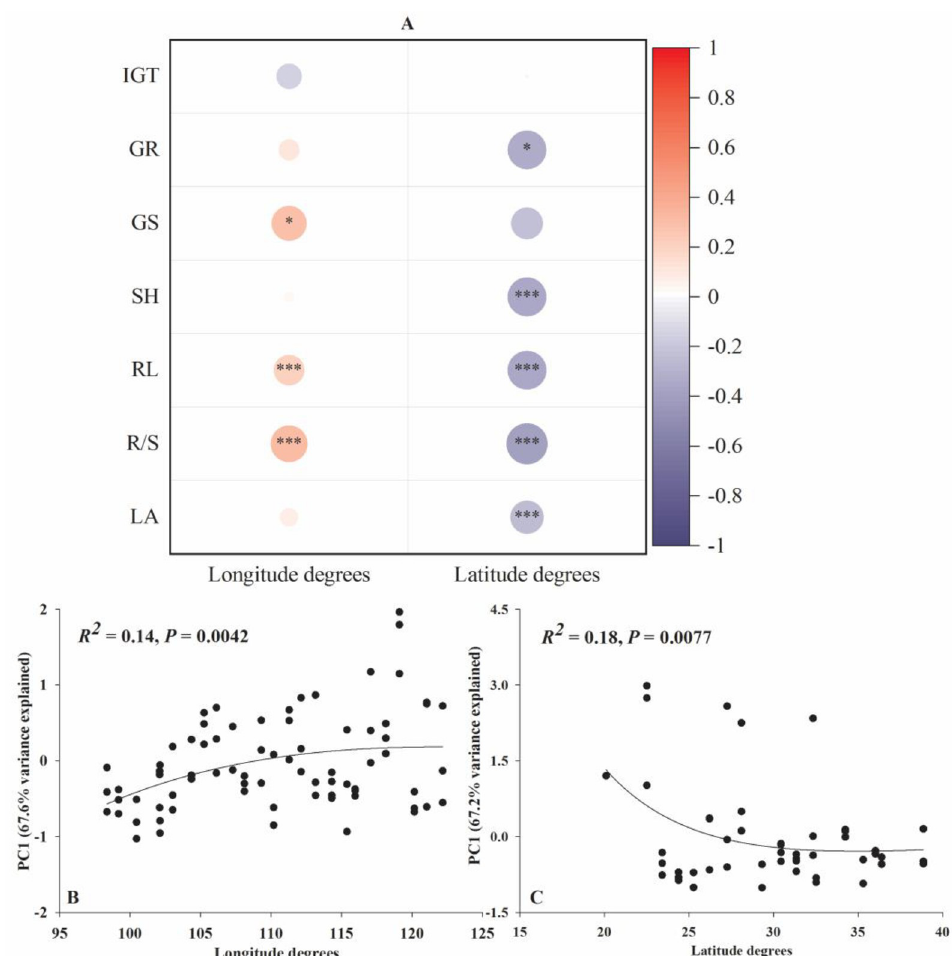
Fig 2. The relationships between the seed germination and seedling growth indices (A) and the PC1 eigenvalues of these indices (B and C) of L . sativa along the latitude and longitude degrees. IGT, GR, GS, SH, RL, R/S and LA represent initial germination time, germination rate, germination speed, shoot height, root length, root length:shoot height ratio and leaf area, respectively. ‘ � ’, ‘ �� ’ and ‘ ��� ’ signify p < 0.05, p < 0.01 and p < 0.001,